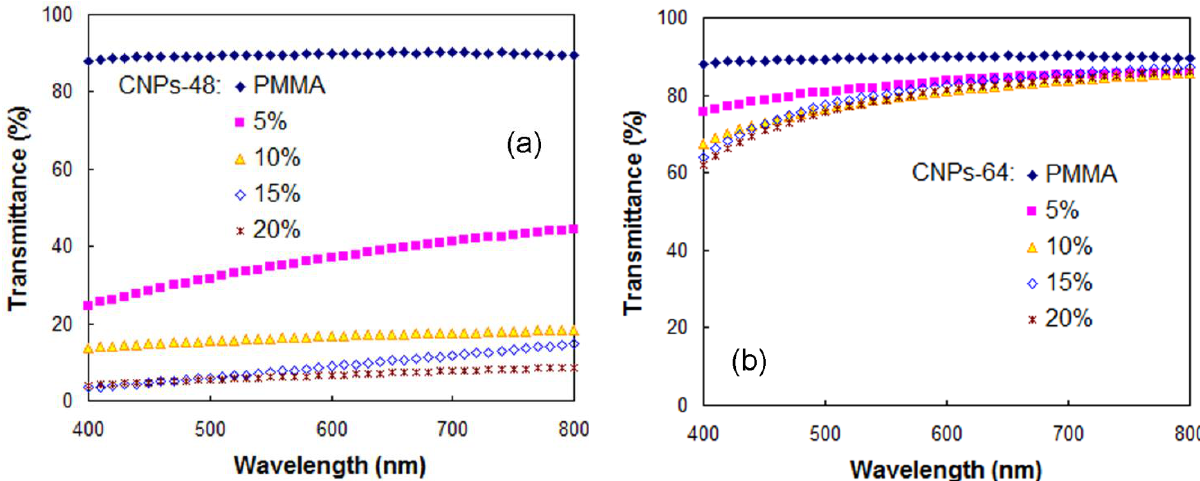
Figure 4. UV-vis transmittance spectra of pure PMMA and CNP/PMMA composites reinforced with ( a ) CNPs-48 and ( b )